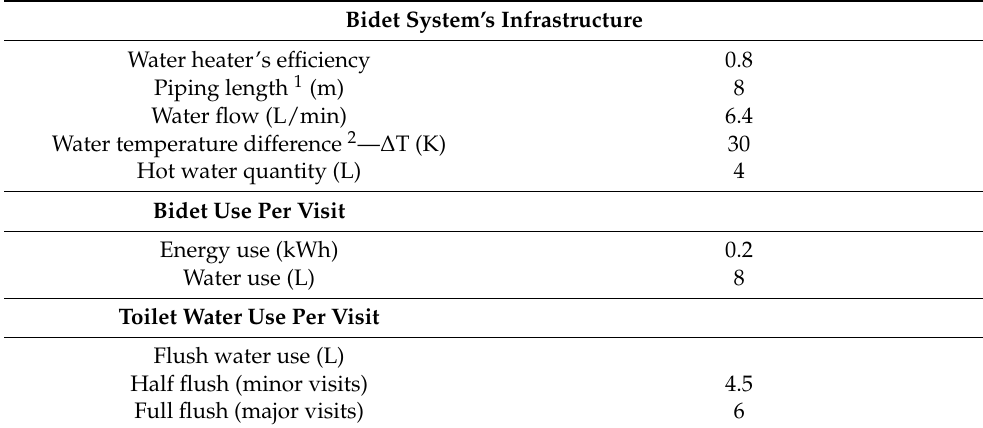
Table 5. Toilet and bidet energy and water use inventory. Source: Developed by the authors using data collected by the author affiliated with OLI and from the